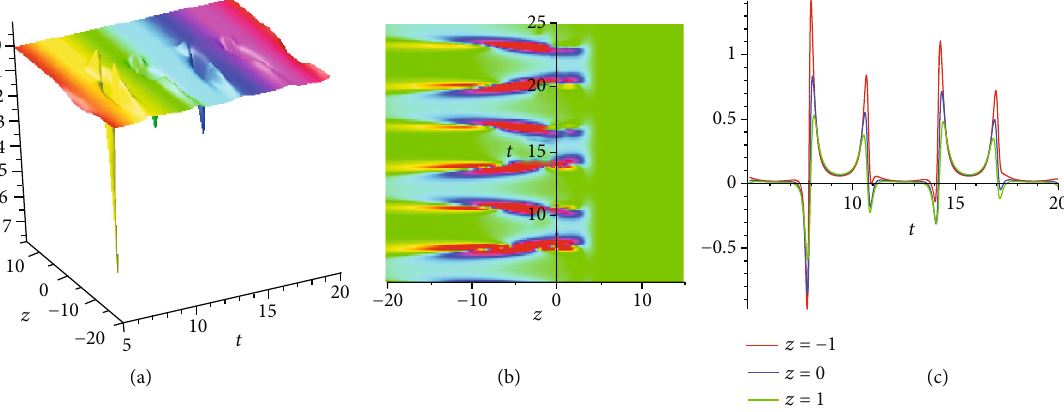
Figure 12: Plots of interaction with two lumps-soliton (59).